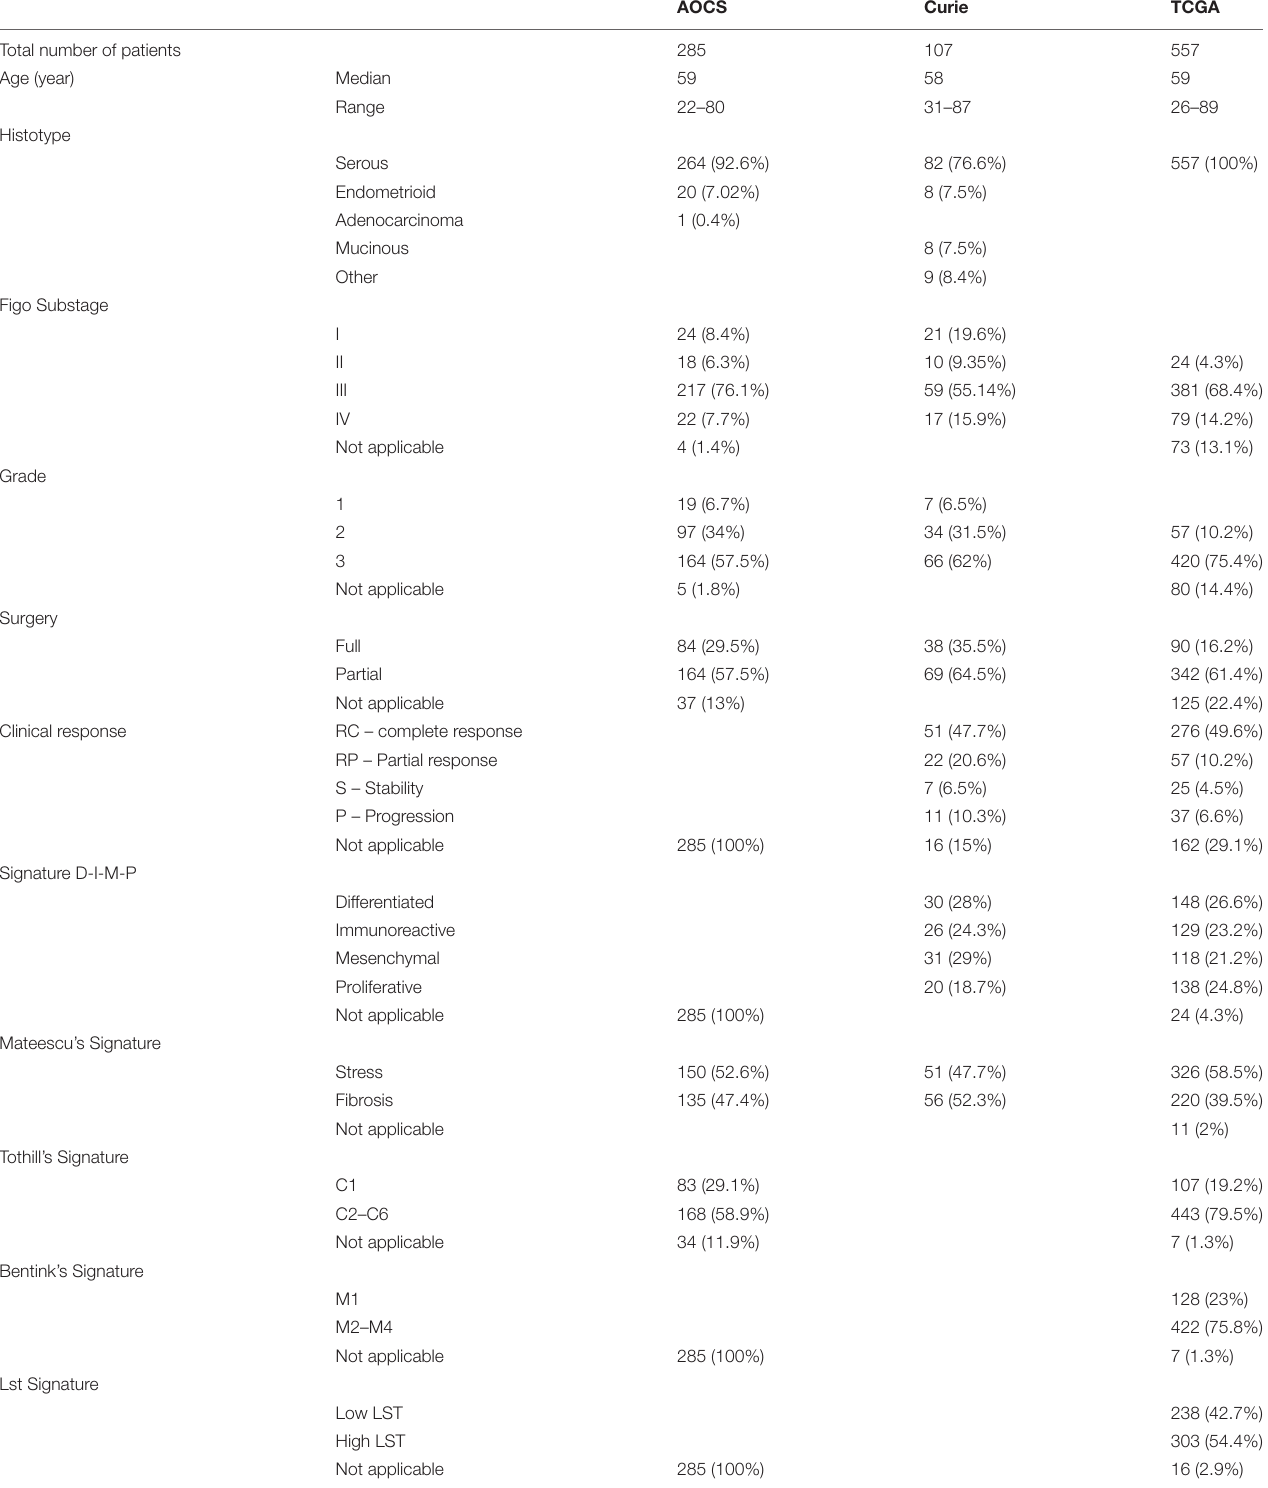
TABLE 1 | Comparative description of clinical parameters in the AOCS, Curie, and TCGA